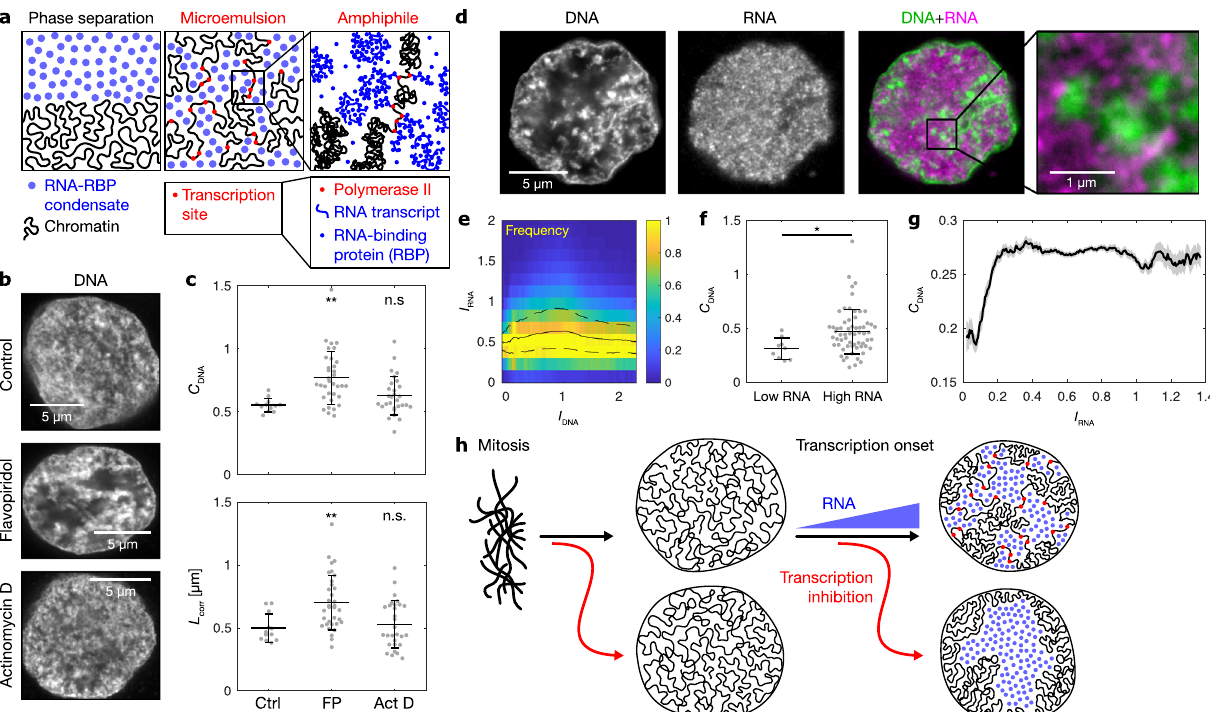
Fig. 2 RNA accumulation establishes euchromatin domains, which are maintained in a fi nely dispersed pattern by transcriptional activity. a Cartoon representation of conventional phase separation and a microemulsion. Right panel focuses on the amphiphile in the microemulsion. b Representative micrographs of nuclear mid-sections obtained from cells treated for 30 min with the indicated inhibitors. The same results were obtained in two independent experiments. c Quanti fi cation of DNA image contrast ( C DNA ) and correlation length ( L corr ) for the different inhibitor treatments: control treatment (Ctrl), fl avopiridol (FP), actinomycin D (Act D). Mean± SD, ** indicates P < 0.01, n.s. indicates P ≥ 0.05 ( C DNA P values 0.002, 0.22 from a two- sided permutation test, L corr P values 0.007, 1.2 from a two-sided permutation test, P values with Bonferroni correction for multiple testing, n = 12,34,29 nuclei from four, three, four different samples). d Representative nuclear mid-section of a fl avopiridol-treated cell. The same results were obtained in three independent experiments. e 2D histogram displaying the frequency of pixel-level RNA intensity ( I RNA ) and DNA intensity ( I DNA ). Solid and dashed lines are median and 25th and 75th percentile, respectively. f Quanti fi cation of C DNA and L corr in fl avopiridol-treated cells with low and high levels of RNA (the threshold for high RNA is I RNA = 0.25). Mean± SD, * indicates P < 0.05 ( P value 0.03 from a two-sided permutation test, n = 9,62 from fi ve